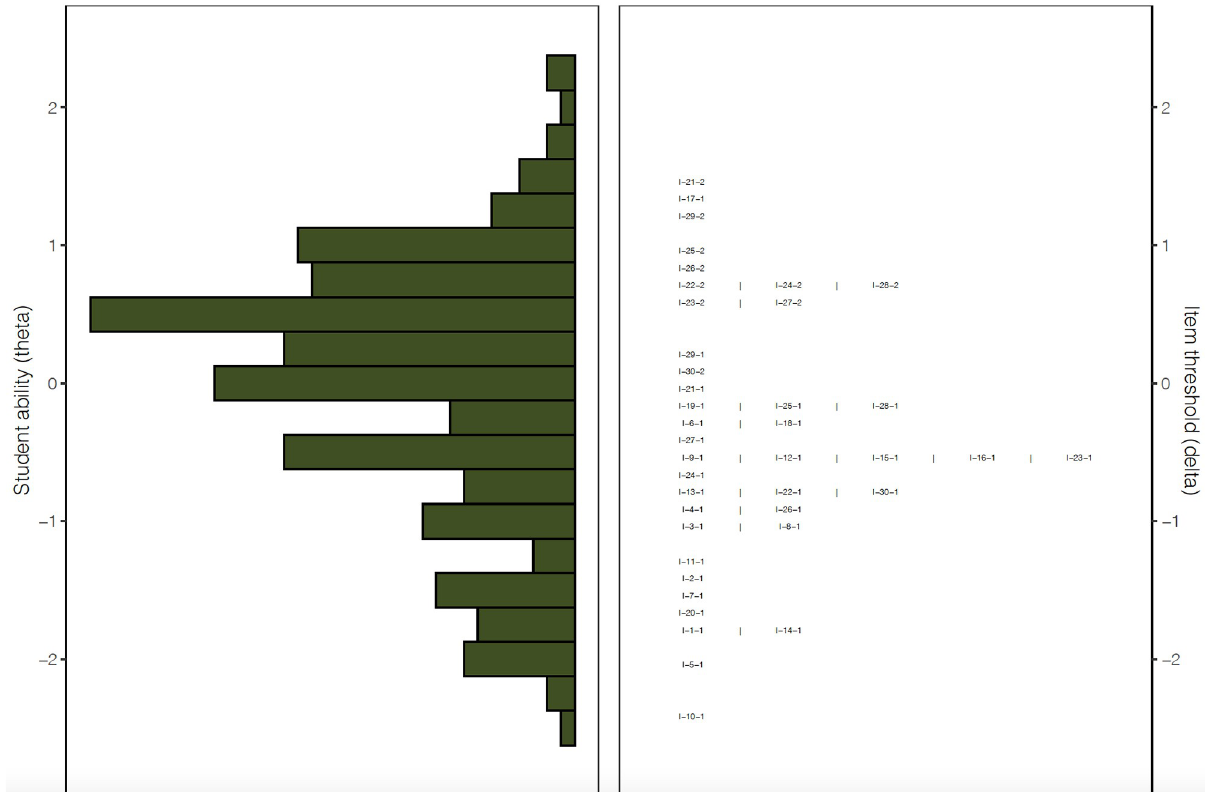
Fig 3. Exposition of dichotomous and partial credit thresholds in Wright map. Note . I- 21-2 represents the item difficulty threshold for the partial credit scores of 0, 1, and 2.